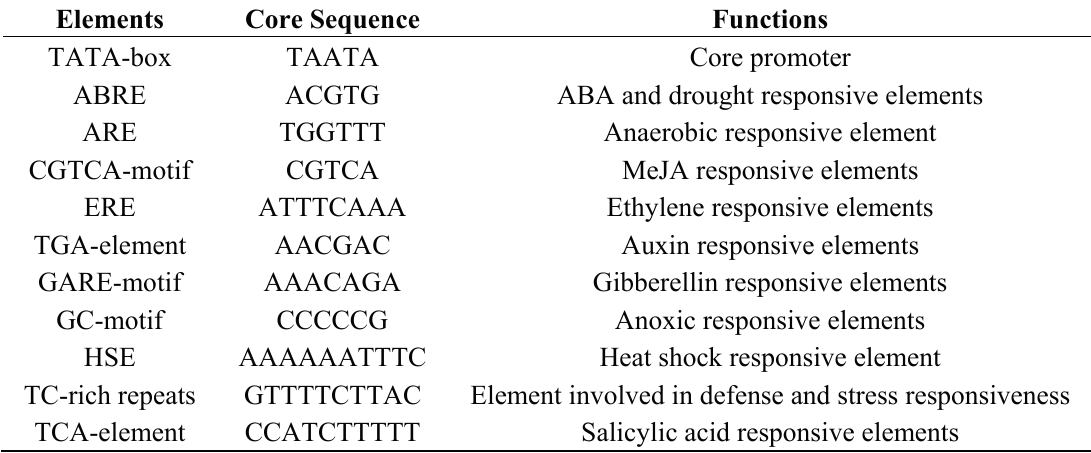
Table 1. Analysis of putative cis -acting elements in the wheat W36